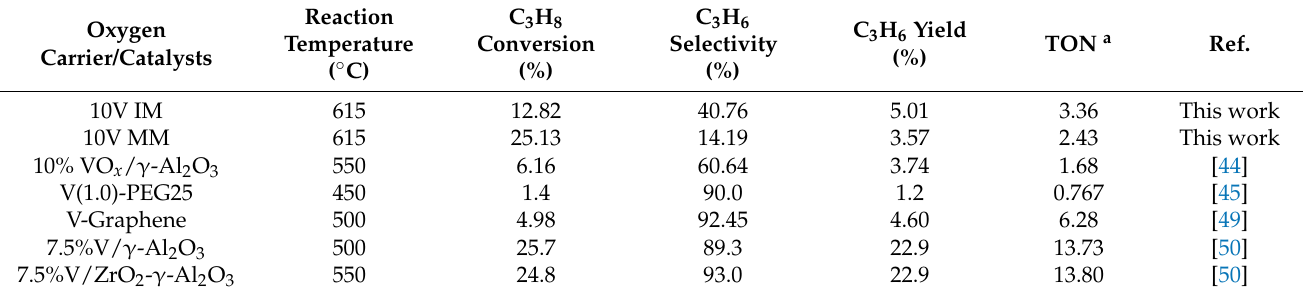
Figure 7. The ODHP reaction performance for 10V IM and 10V MM at 615 ◦ C. Table 2. The comparison of different V-based oxygen